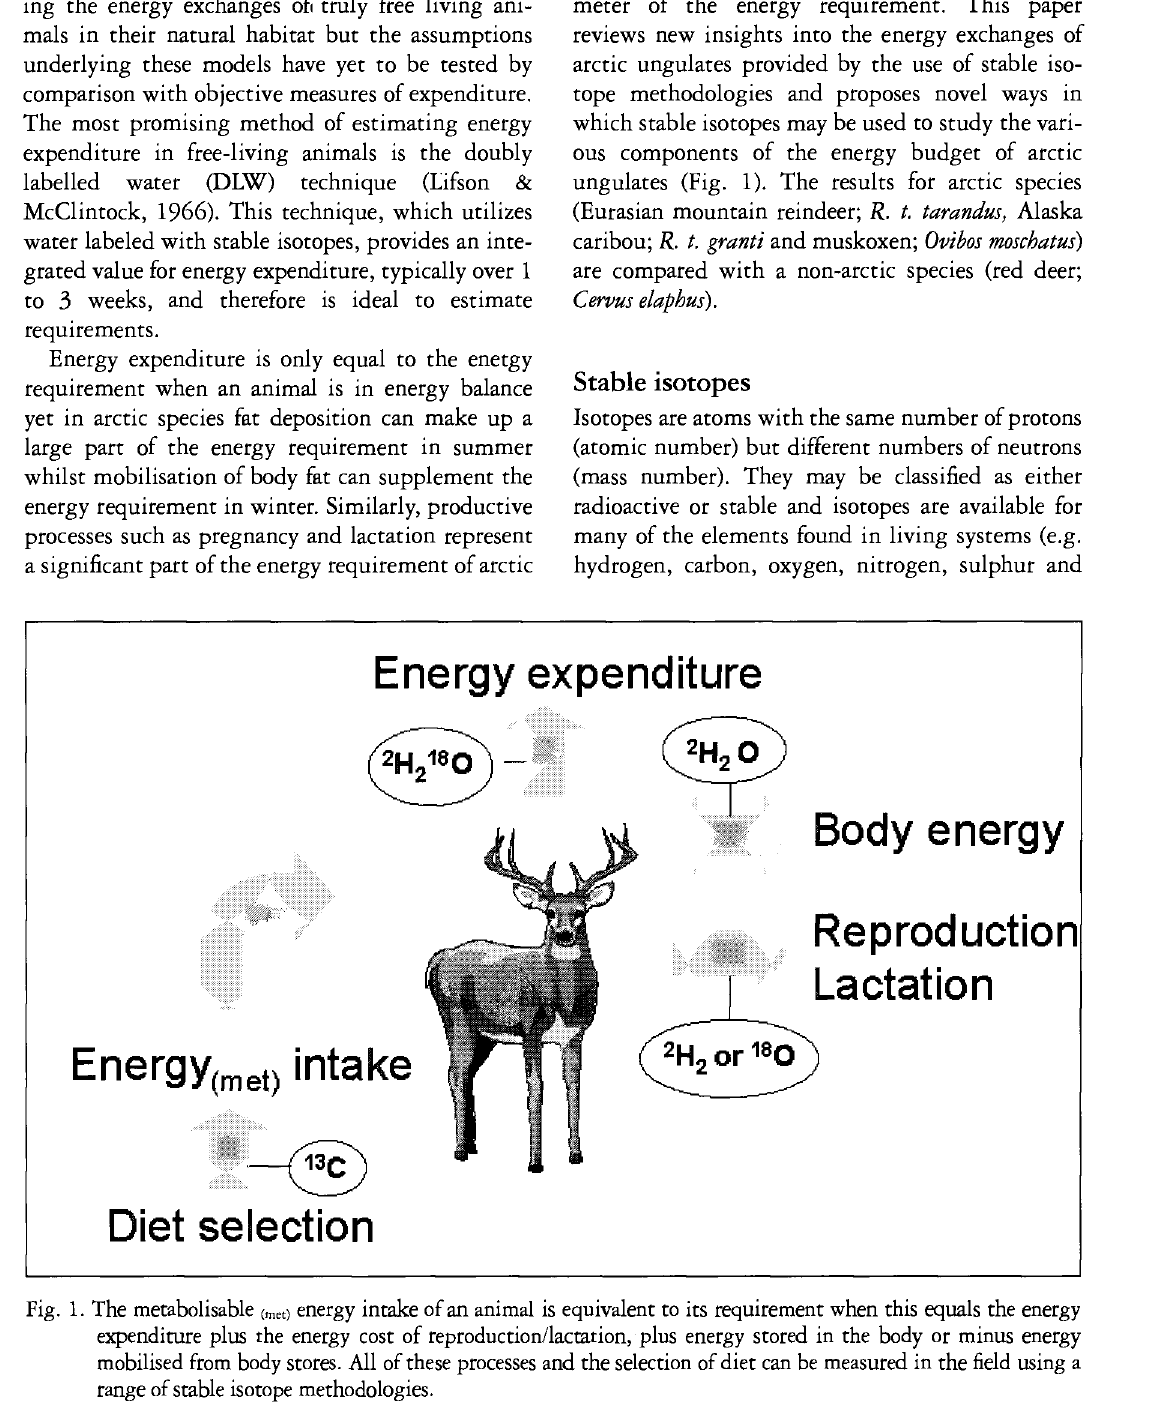
Fig. 1. The metabolisable ( ) energy intake of an animal is equivalent to its requirement when this equals the energy met expenditure plus the energy cost of reproduction/lactation, plus energy stored in the body or minus energy mobilised from body stores. All of these processes and the selection of diet can be measured in the field using a range of stable isotope